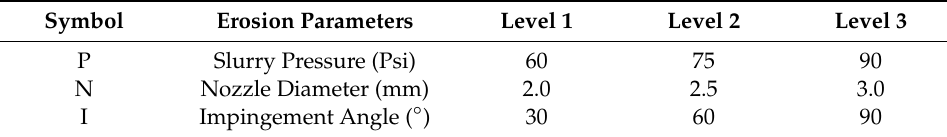
Table 1. Machining parameters and